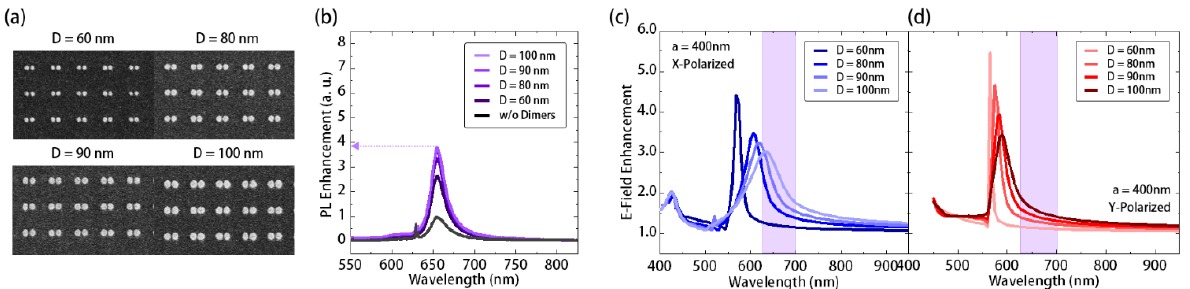
Figure 4. ( a ) The SEM images of silver ND-dimer arrays with D values from 60 to 100 nm; ( b ) the measured PL spectra of MoS 2 covering these silver ND arrays after embedding in PDMS; theoretical electrical field enhancement of ( c ) X - and ( d ) Y -polarized SLR modes under different wavelengths in silver ND-dimer arrays with different D .